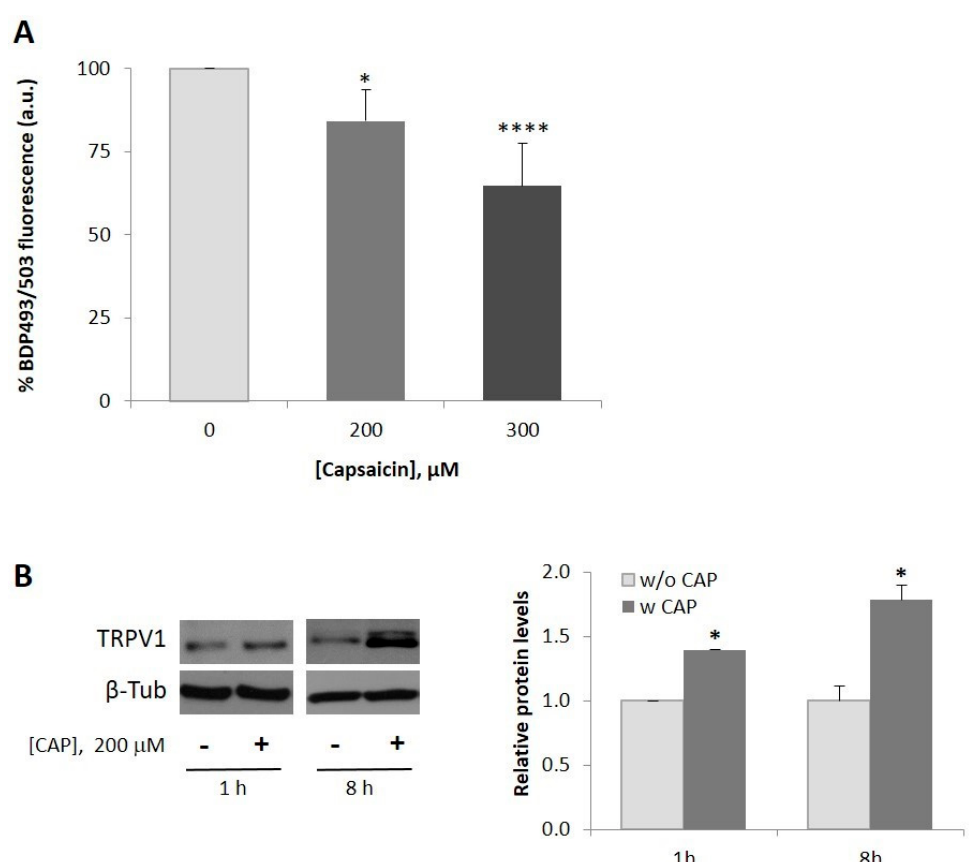
Figure 1. Capsaicin reduces neutral lipid content in HepG2 cells. HepG2 cells were cultured in EMEM medium without serum for 24 h. ( A ) Measurement of neutral lipid content in HepG2 cells. Cells were treated with or without 200 μ M or 300 μ M capsaicin for 24 h. Intracellular neutral lipids were stained with bodipy 493/503 (BDP 493/503) for 30 min and fluorescence was measured by flow cytometry